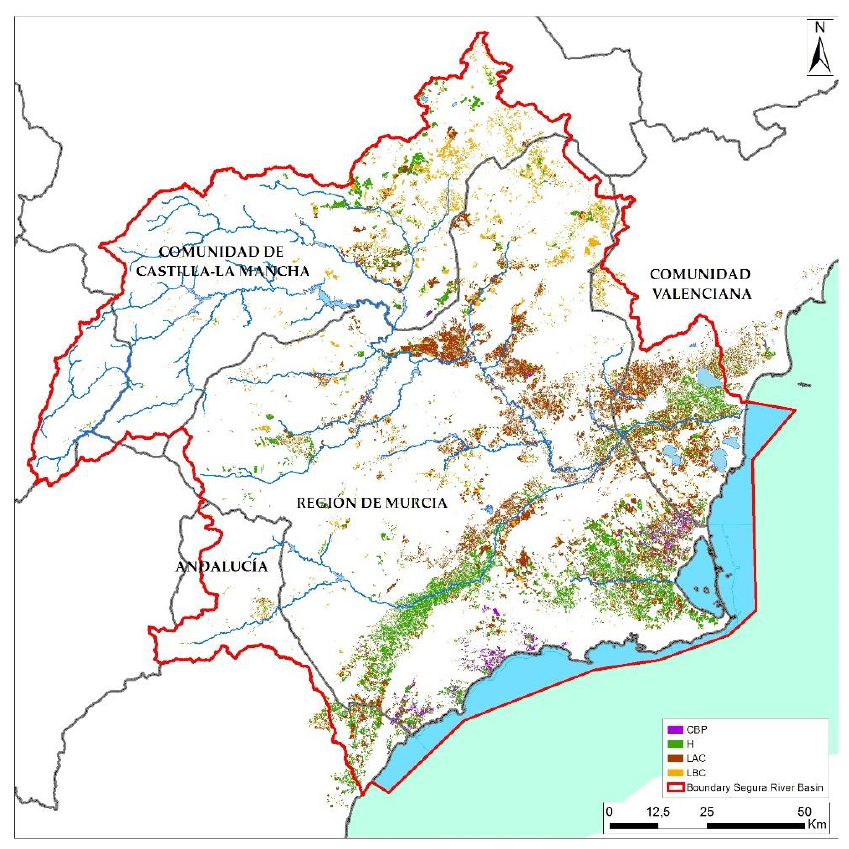
Figure 3. Map of irrigated crops (year 2015). Source: “Estudios de Cuantificación de la Superficie Regada mediante Teledetección y SIG en la Cuenca del Segura”, Own elaboration. Regada mediante Teledetecci ó n y SIG en la Cuenca del Segura”, Own